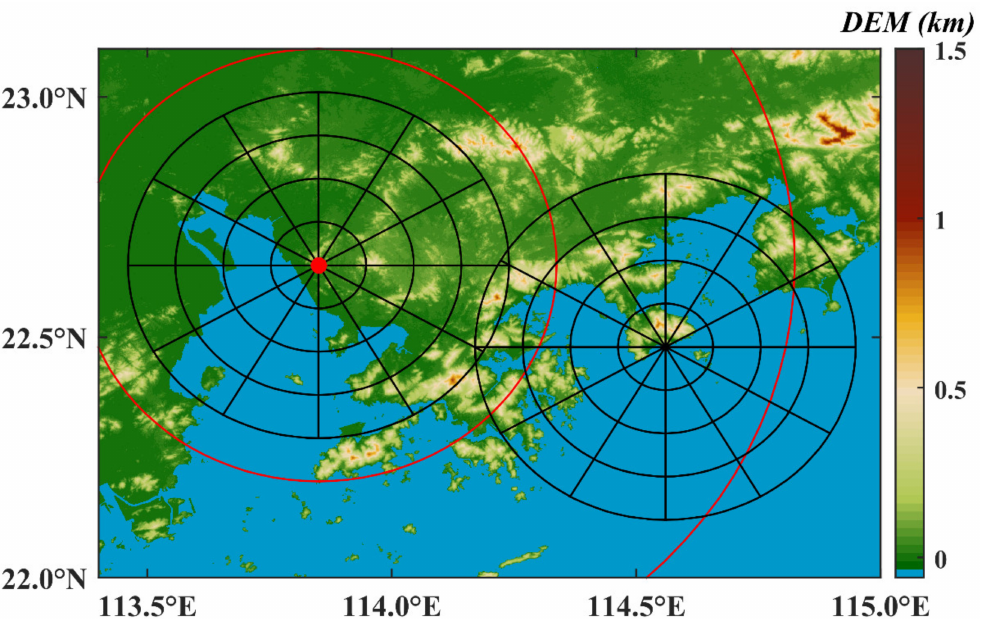
Figure 1. Location and Digital Elevation Model (DEM) information of the S-POL and two X-PARs. The center of the red and black circles shows the sites of the S-POL and X-PARs, respectively. The distance of the black concentric circle is 10 km, and the distance of the red concentric circle is 50